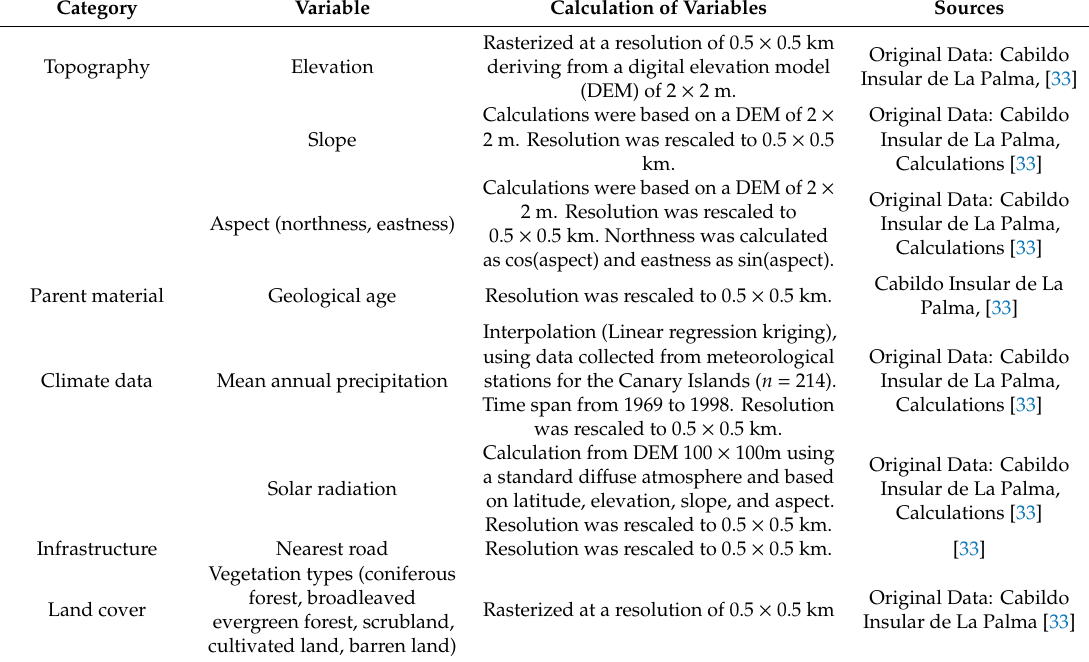
Table 1. Environmental variables used for species distribution modeling of suitable habitat of P. setaceum on La Palma, including also the calculations of variables and the